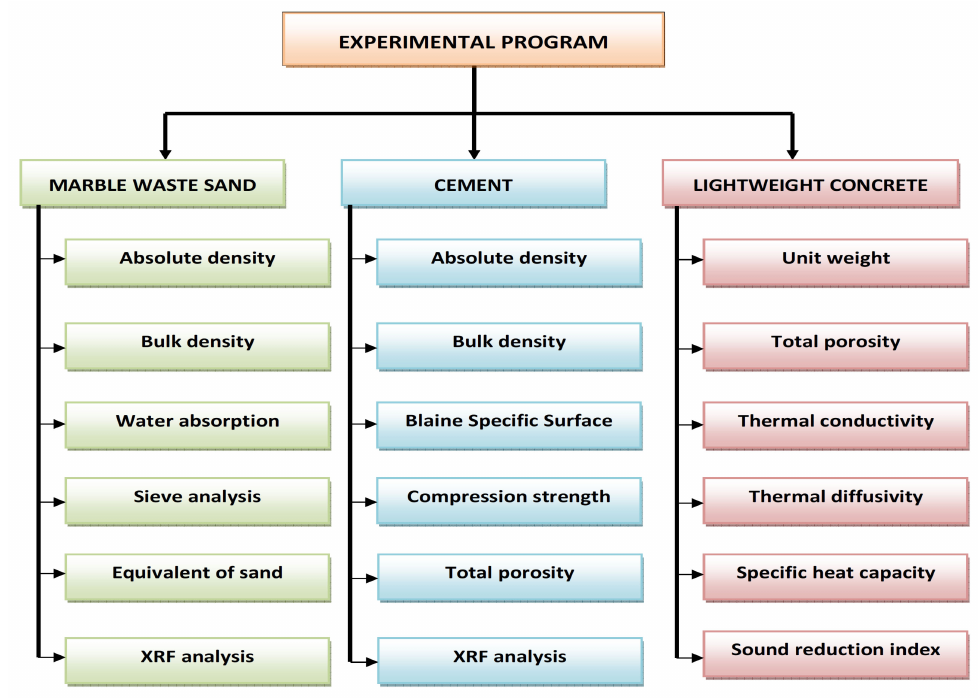
Figure 1. Flow chart of the experimental program.